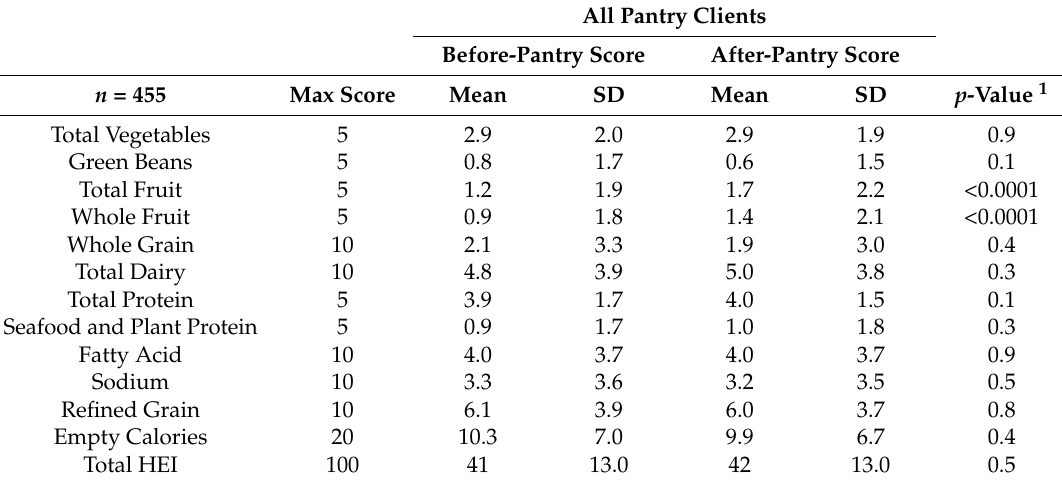
Table 3. Comparison of before and after pantry HEI-2010 total and component scores in a multistate sample of rural, Midwestern, adult emergency food pantry clients for all pantry clients and for food-insecure pantry clients ( n =